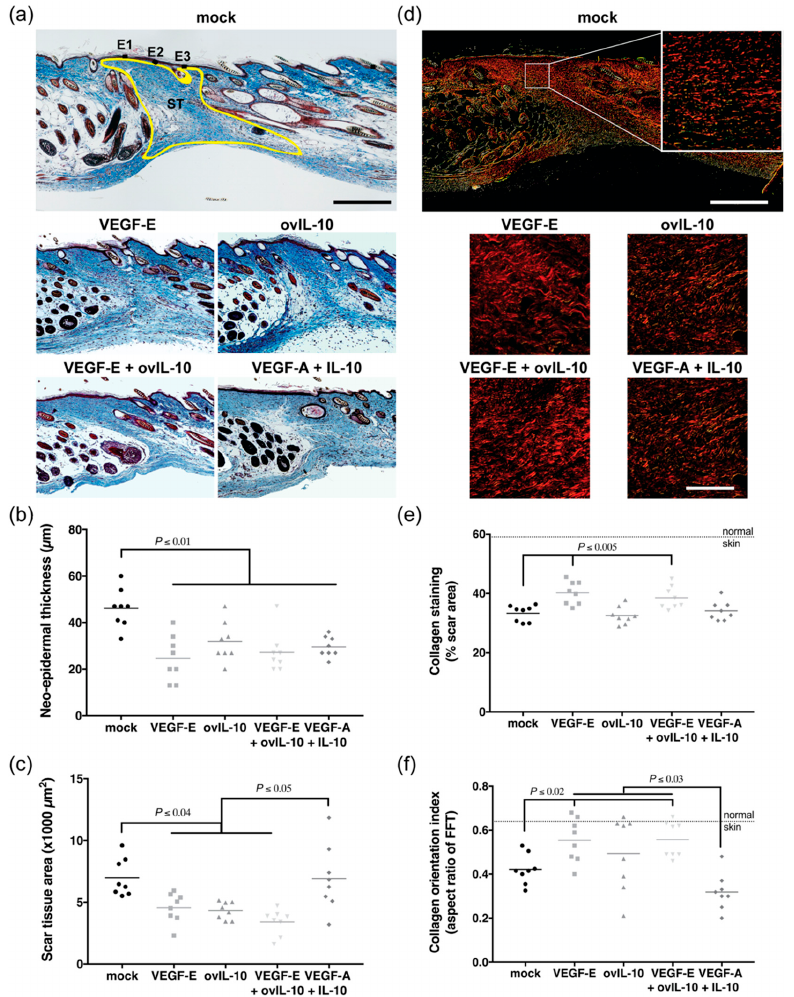
Figure 6. VEGF-E and ovIL-10 have complimentary effects on scar size and quality. ( a ) Representative images of MSB trichrome-stained day 16 wound sections after four SC injections of the indicated treatment. The sites of epidermal (E1–3) measurement are indicated and scar tissue area (ST) is outlined in yellow. Scale bar = 300 µm. ( b ) Thickness of the neo-epidermis in healed skin given the indicated treatments. ( c ) Scar tissue area in healed skin following the indicated treatments. Data are presented with each symbol representing an individual wound, and the line indicating the mean of 8 wounds, p values are indicated. ( d ) Representative image of picrosirius red-stained day 16 wound section visualised under dark-field with a polarised filter. Scale bar = 300 µm. Enlarged images show collagen density and orientation in ST adjacent to the neo-epidermis after four SC injections of the indicated treatment. Scale bar = 50 µm. ( e ) Percentage area of collagen staining in healed skin following the indicated treatment. ( f ) Collagen orientation indices (W/L ratio from zeroth-order maximum plot generated using FFT) in healed skin following the indicated treatments. Data are presented with each symbol representing an individual wound, and the line indicating the mean of 8 wounds, p values are indicated.